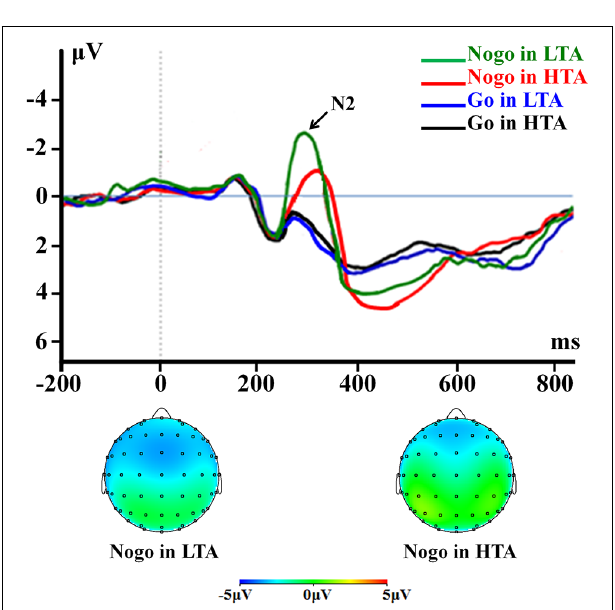
FIGURE 3 | The N2 component time-locked to the Go and NoGo conditions. Event-related potentials (ERPs) were calculated by averaging the data at the electrodes of Fz, F1, F2, FCz, FC1, FC2, Cz, C1, and C2.